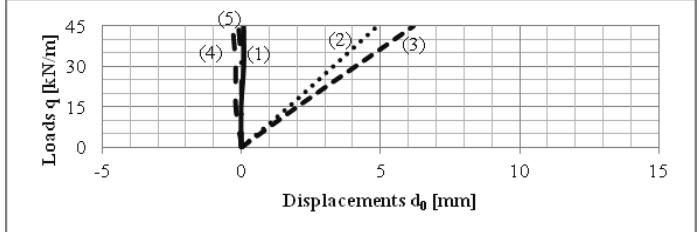
Fig. 6b. Displacements d 0 (mm) depending on the use of sheet piles as a cover of the foundation. Horizontal load applied at the bearing points